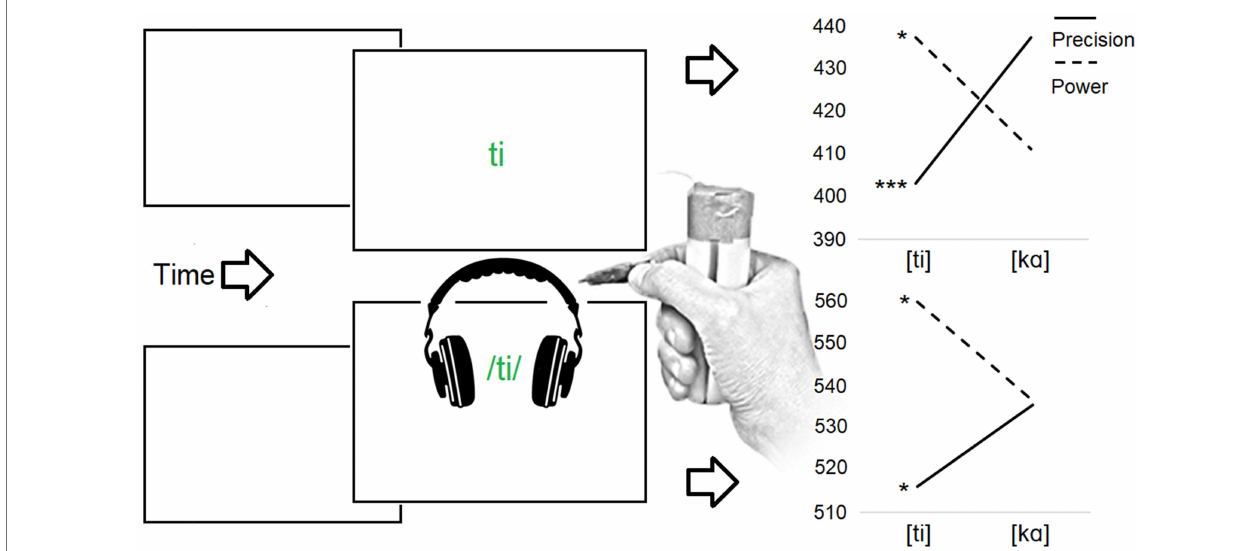
FIGURE 1 | (Above) The reaction time (RT) effect for the study published by Vainio et al. (2013). In the experimental task, the participants were visually presented with a syllable (e.g., [ti] or [ka]). The participants had to respond by squeezing a precision or power grip device according to the color (green/blue) of the syllable while simultaneously pronouncing the syllable. Precision grip responses were performed particularly and rapidly with the syllable [ti], while power grip responses were performed particularly rapidly with the syllable [ka]. (Below) The RT effect for the study published by Vainio et al. (2014). In the experimental task, the participants were aurally presented with the syllable [ti] or [ka] at a high or low pitch. The participants had to perform either precision or power grip response based on the pitch cue. Precision grip responses were performed particularly rapidly with the syllable [ti], while power grip responses were performed particularly rapidly with the syllable [ka]. Asterisks indicate statistically significant differences (*** p < 0.001; * p <